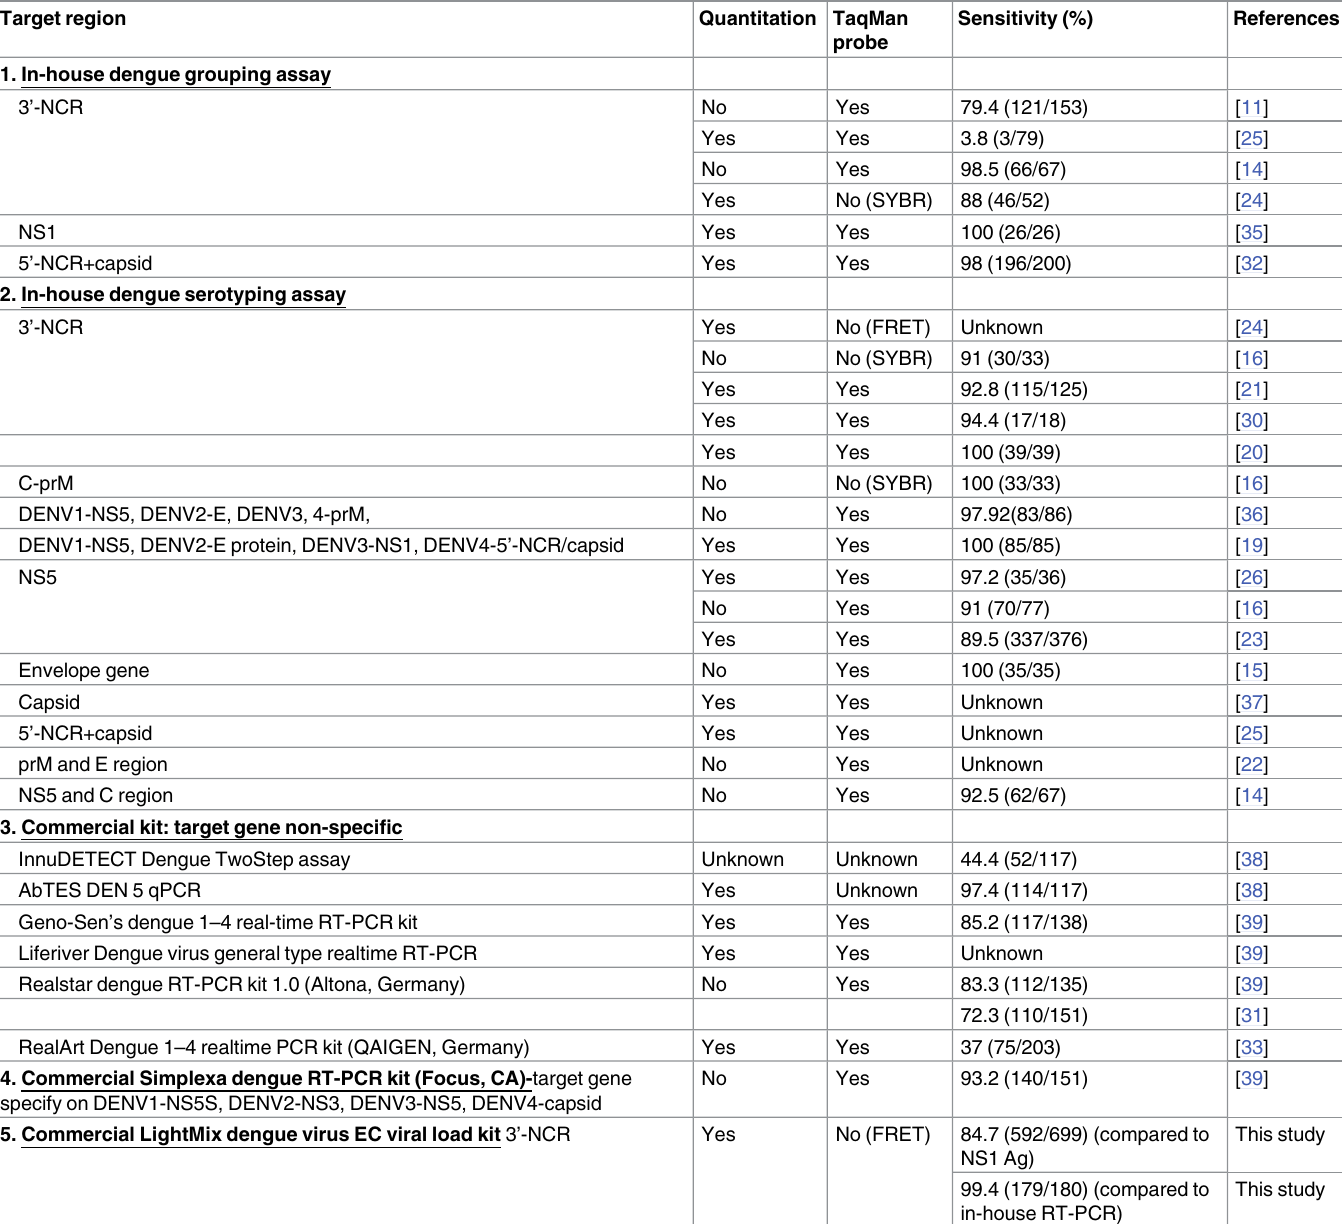
Table 5. Comparison of published real-time reversetranscriptase-polymerase chain reaction methods for detection of dengue